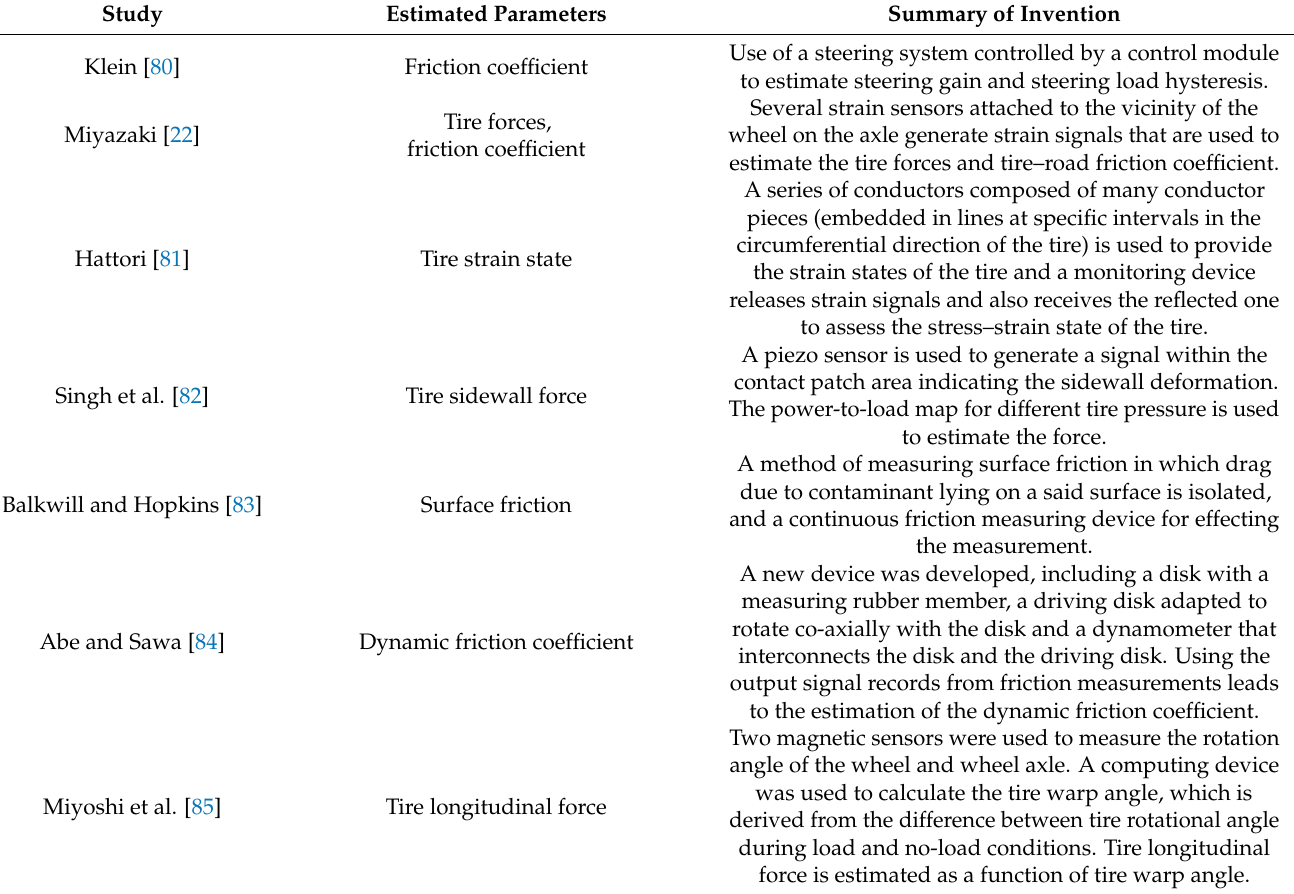
Table 1. Experimental-based methods to estimate friction parameters (adapted from